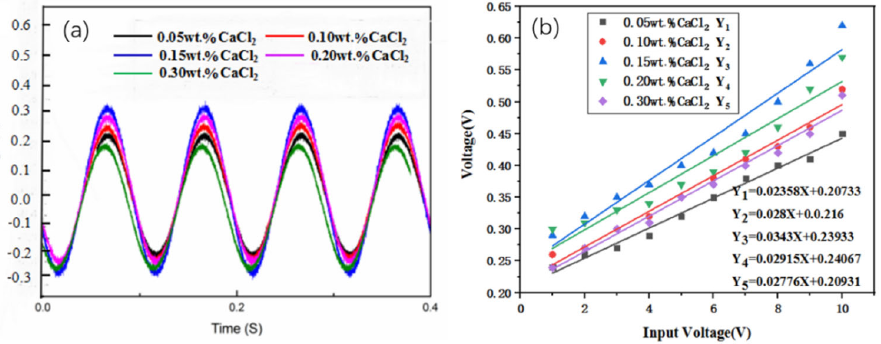
Figure 8. ( a ) Output voltage of single-layer film sensor and ( b ) relationship between output and input voltages of single-layer film sensor.